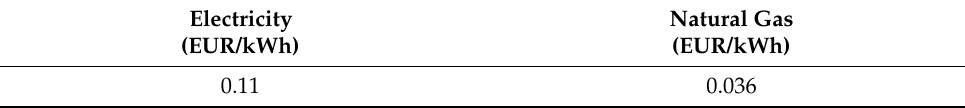
Table 1. Natural gas and electricity prices.